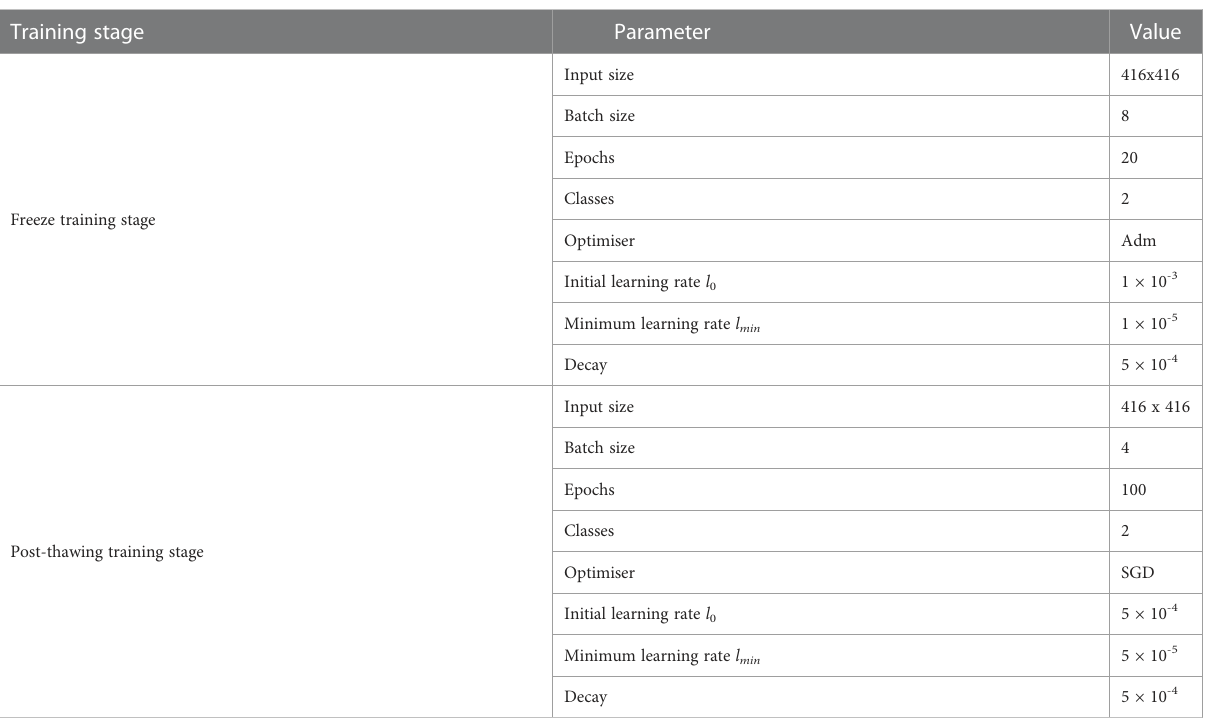
TABLE 2 Training parameters of YOLO v4 wheat seed detection model.